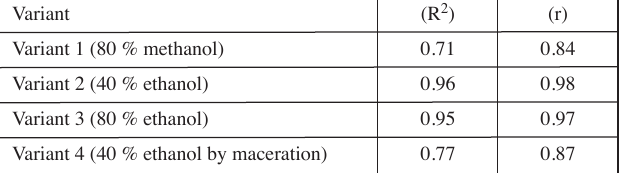
Tab. 3: Correlation coefficients (r) and coefficient of determination (R 2 ) of total phenolics and anti-oxidant